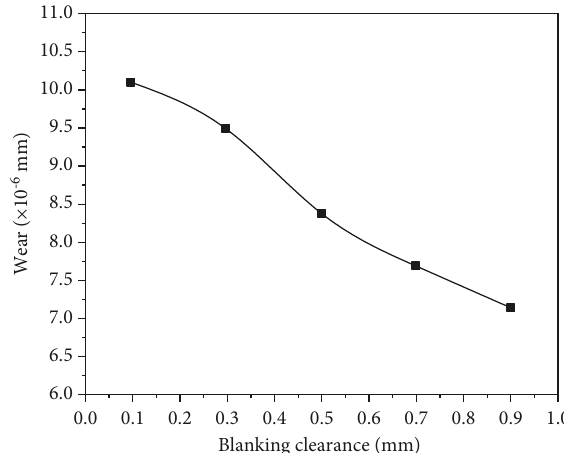
Figure 4: Effect of blank holder force on die wear.